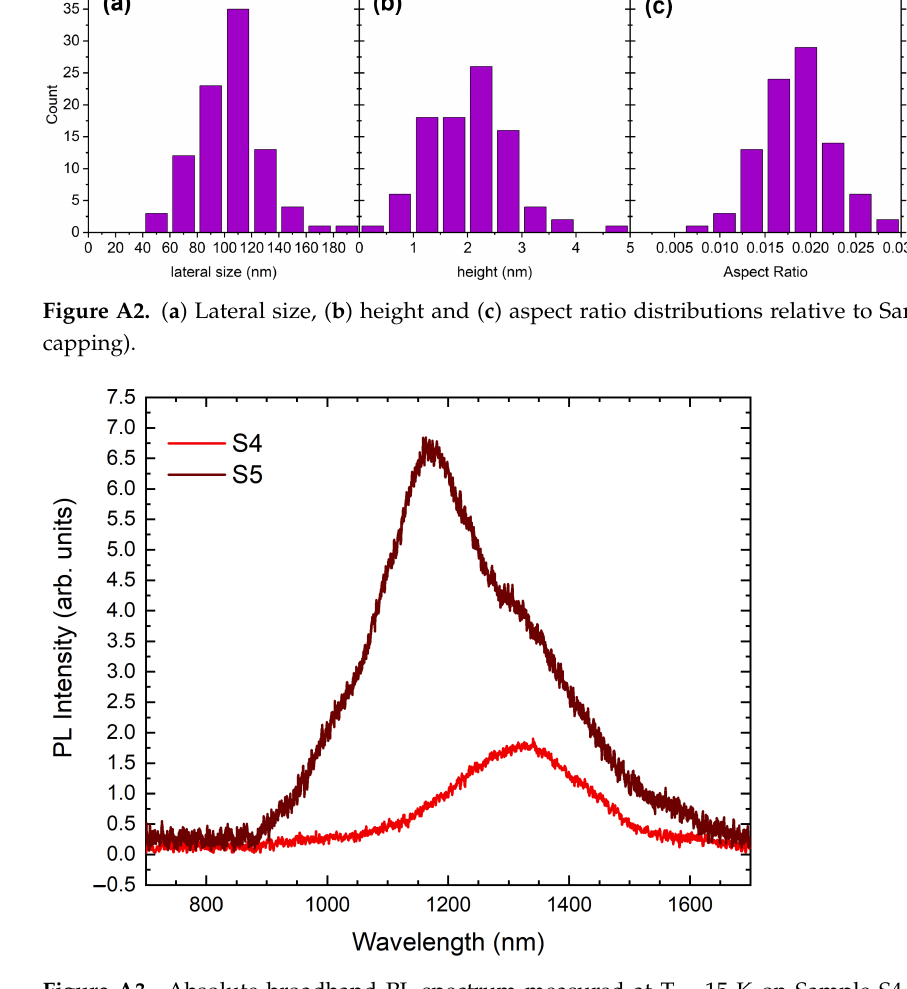
Figure A3. Absolute broadband PL spectrum measured at T = 15 K on Sample S4 (bright red, obtained by capping a sample identical to S1 (shown in Figure 1a) and Sample S5 (dark red, obtained by capping a sample identical to S6 (shown in Appendix A, Figure A1) and exciting with a 405 nm laser with power density of ∼ 4.5 kW · cm − 2